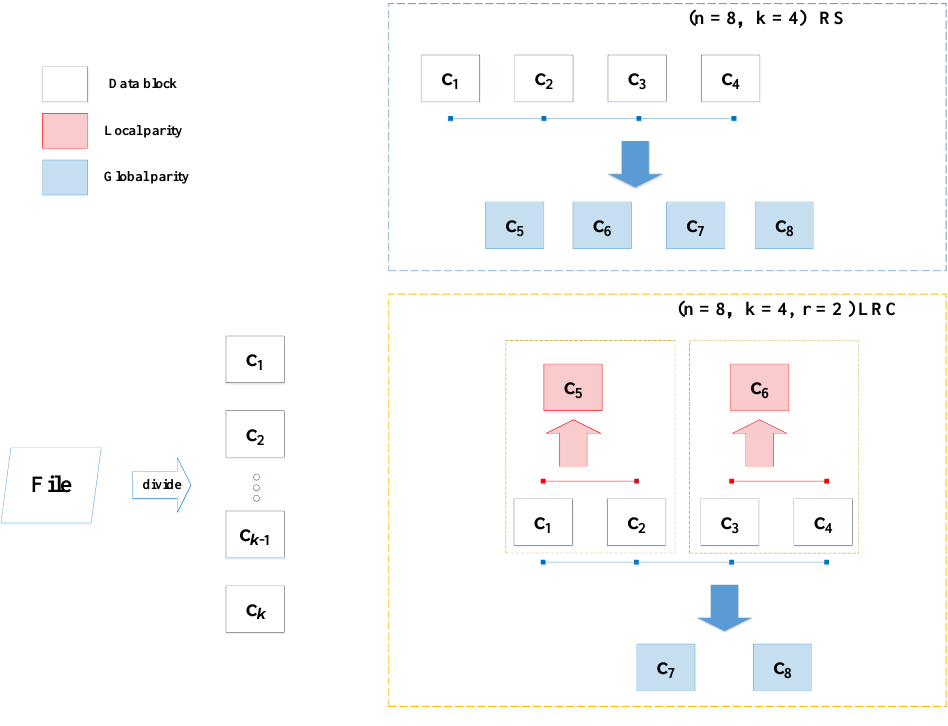
Figure 1. Comparison of [ n = 8, k = 4] Reed-Solomon (RS) code and [ n = 8, k = 4, r = 2] locally repairable codes (LRC)